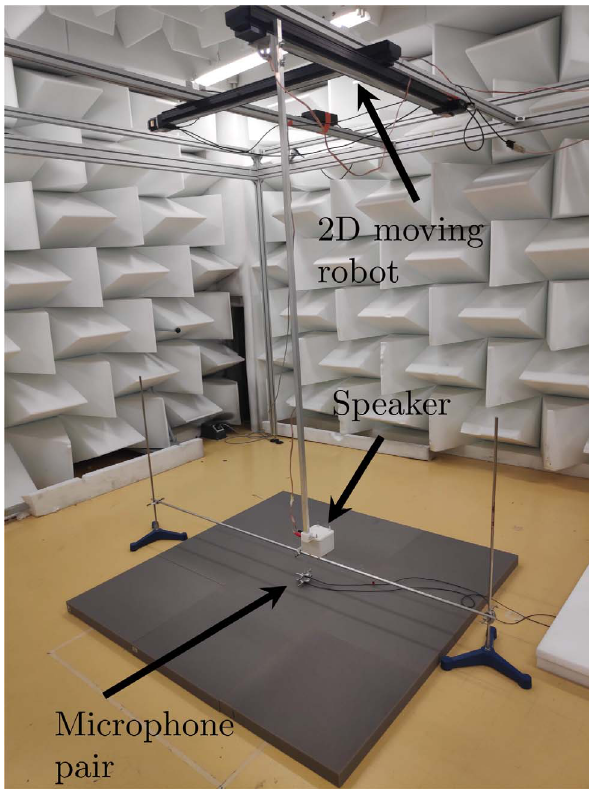
Figure 16. Picture showing the experimental set-up with a single mobile